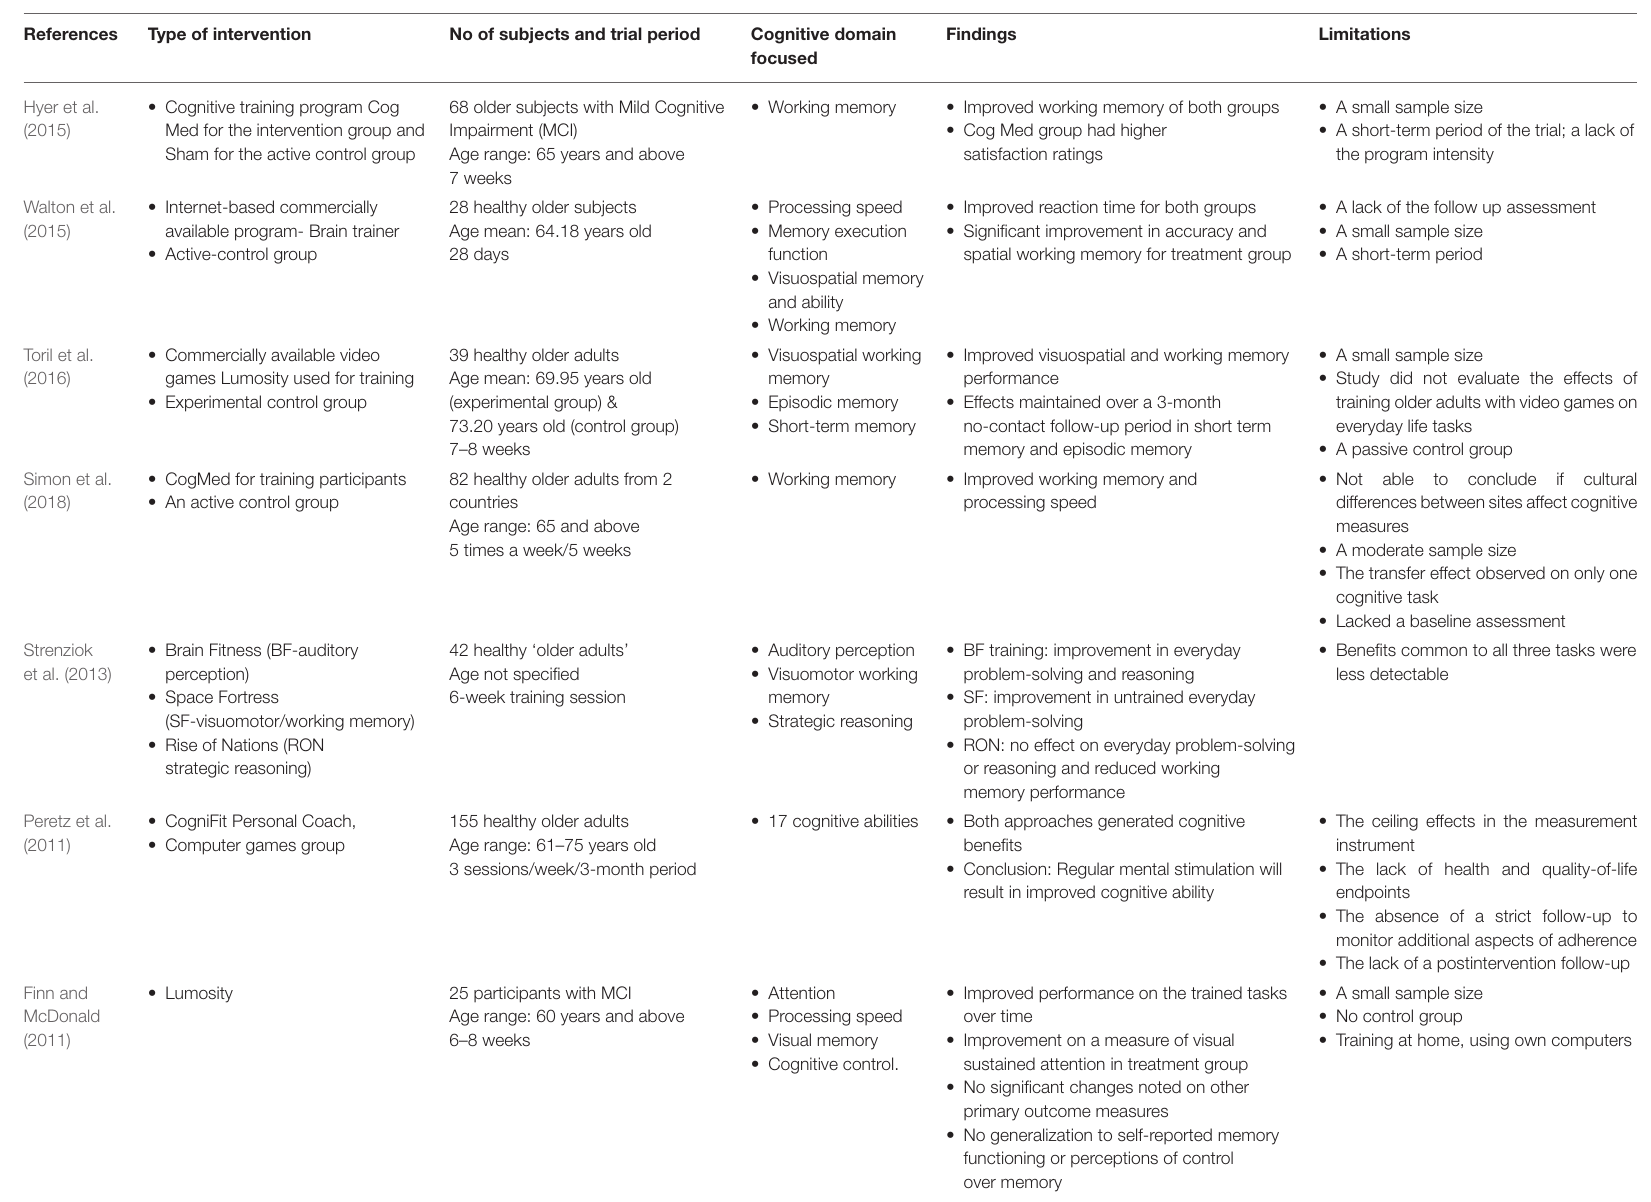
TABLE 3 | Commercially available programs and video